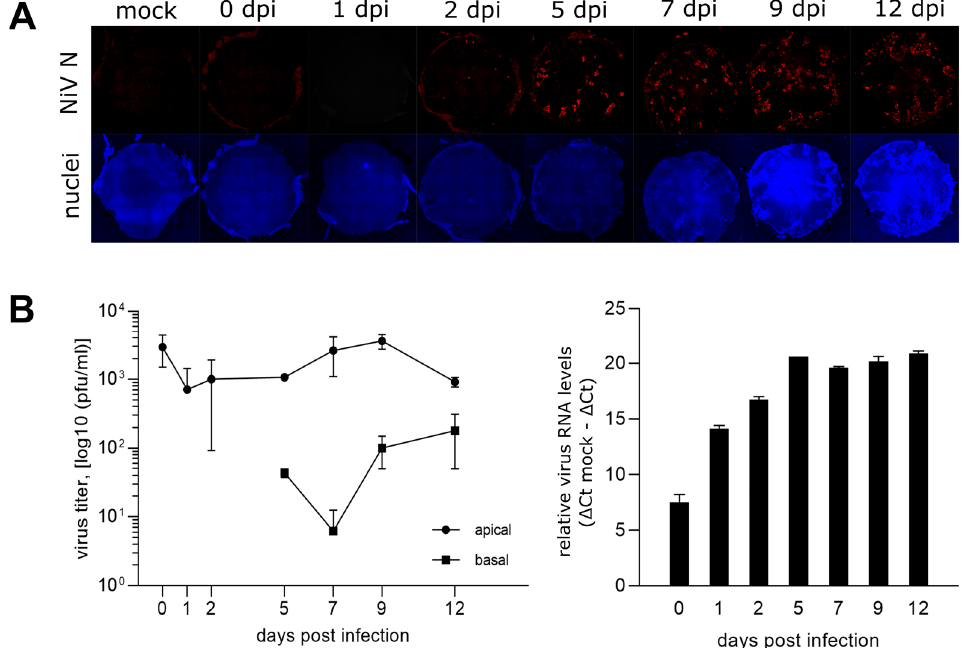
Figure 2. Time course of infected PBEC-ALI cells and virus release. ( A ) Immunostaining of NiV- infected PBEC-ALI membranes against NiV N (red). Nuclei were stained with Hoechst 33342. The diameter of the membranes was approximately 0.64 cm. ( B ) NiV infectious titers at the apical and basal sides. Results are the mean of two replicates with the minimum and maximum values indicated by error bars. On the right, quantification of viral RNA in ALI cultures with NiV N gene primers. The relative virus RNA levels are shown after subtracting ∆ Ct values from the ∆ Ct mock value. N = 2. Error bars indicate the min/max values.